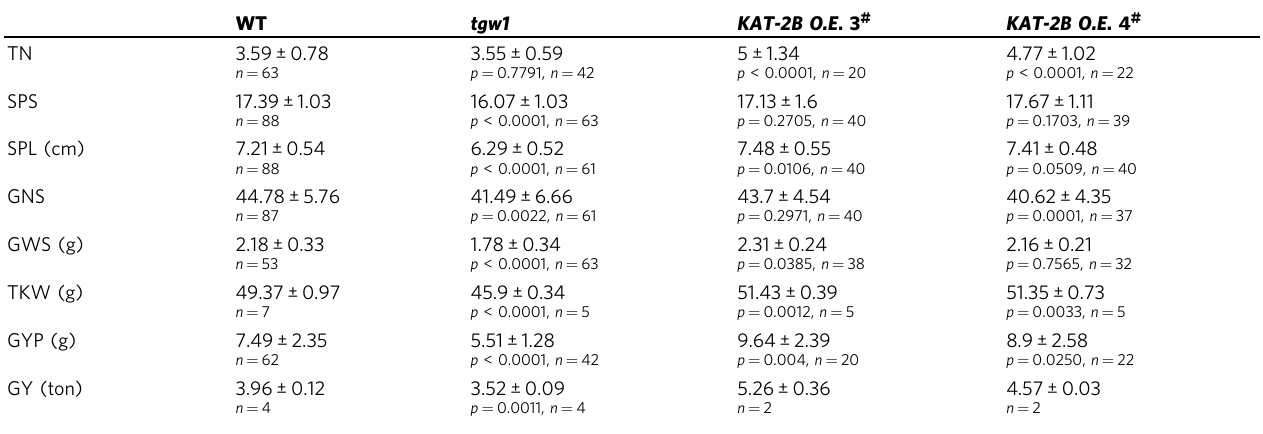
TN Tiller number at harvest, SPS total spikelet number per spike, SPL spike length (cm), GNS grain number per spike, GWS grain weight per spike, TKW thousand kernel weight, GYP grain yield per plant, GY grainyieldperhectare.Dataarerepresentedasmean±SD,and p valuesareindicatedbytwo-tailedunpaired t test.PleaserefertoSupplementaryTable1forJune2019 fi eldtrialdata.Sourcedataare provided as a Source Data fi